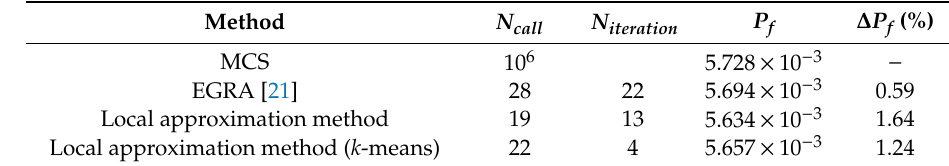
Table 3. Results of the reliability analysis of Example